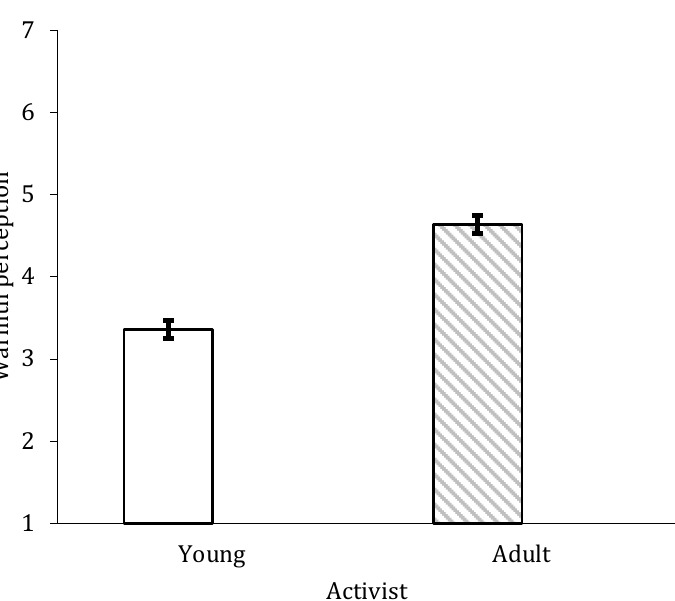
Figure 3. Means and standard errors regarding warmth by experimental conditions.